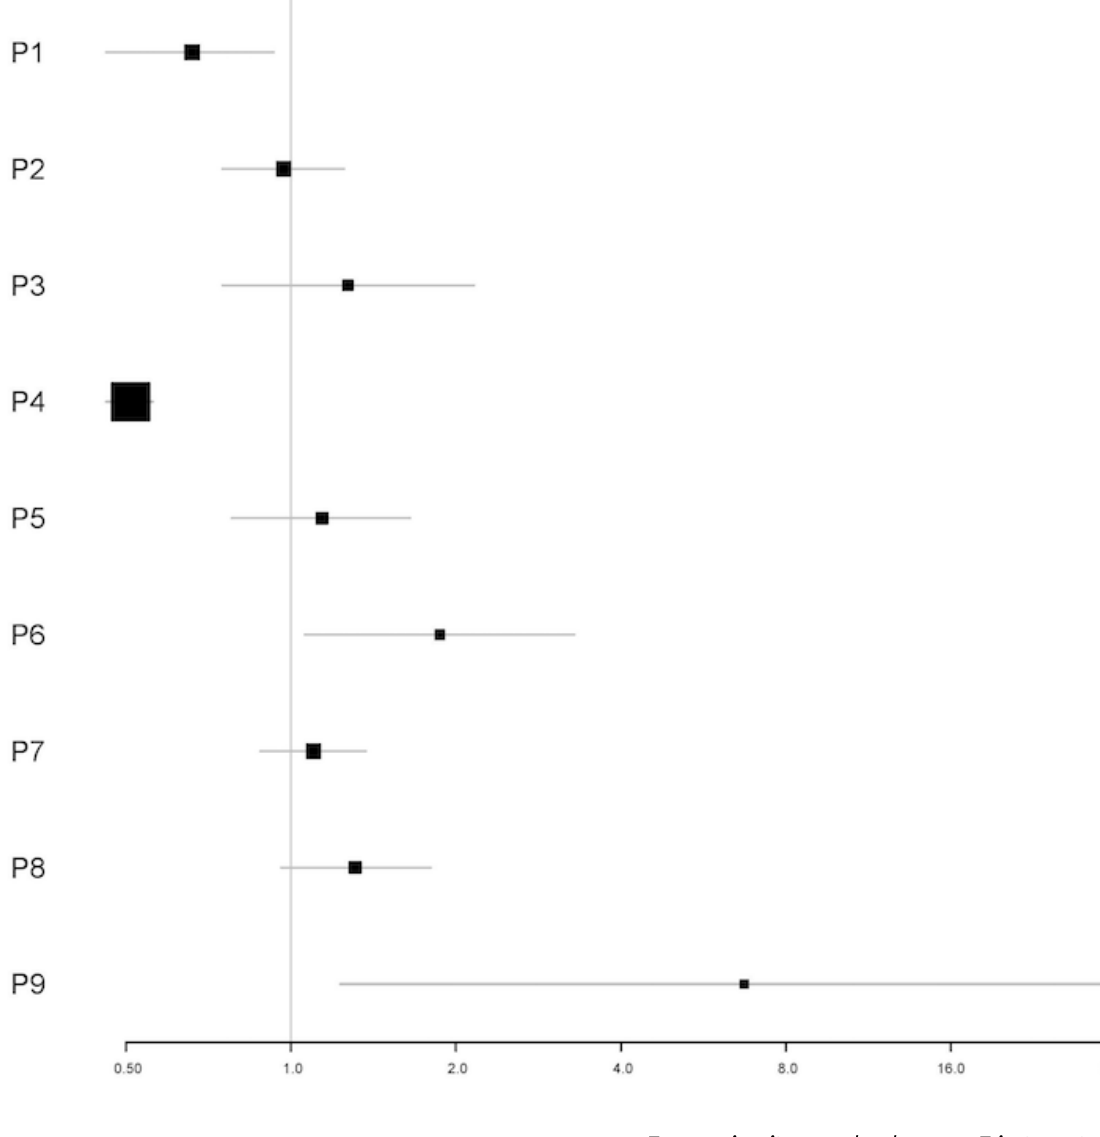
Figure 10. Plot of incidence rate ratios and 95% CIs (x-axis) for the association of perceived lack of time and the amount of engagement for each participant (y-axis) in univariable analyses. P: